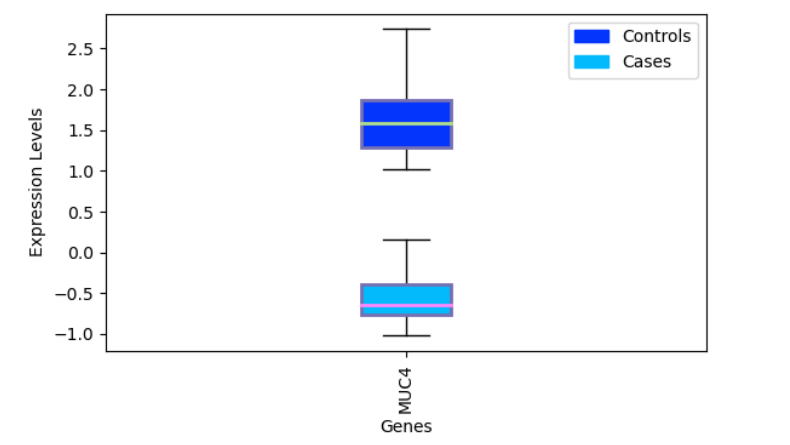
Figure A5. Expression levels of MUC4 and difference between tumor tissue and